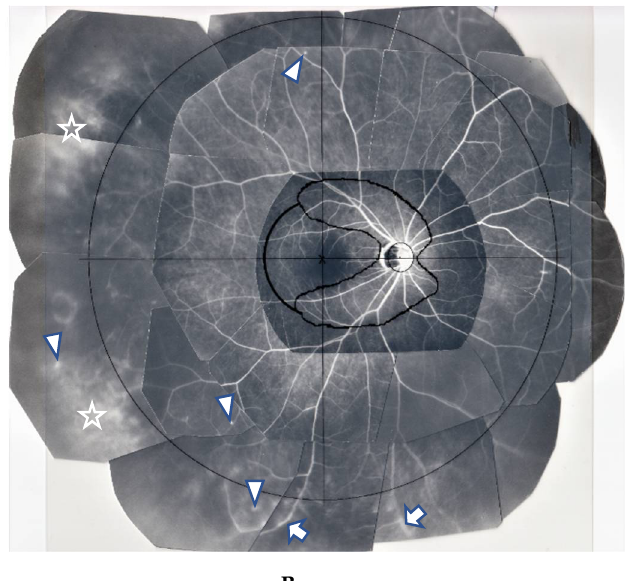
Figure 2. ( A , B ) Images of the right eye of Case 46, a 73-year-old female in Group III with a max IOP of 47 mmHg. Photographs of FGA ( A ) and panoramic FFA ( B ) mounted on a transparent sheet indicating different zones. ( A , inset) Slit-lamp gonioscopy image showing bleeding, possibly from angle NV at the same area as that of FGA. Angle NV observed by FGA showing dot fluorescein staining (arrowhead in A ) and leakage (arrows in A ). Topical betamethasone was not prescribed prior to FGA; ( B ) Panoramic FFA image showing perivasculitis (arrows), granulomas (arrowheads), and chorioretinitis (stars) mostly located in Zone III (extreme peripheral area).